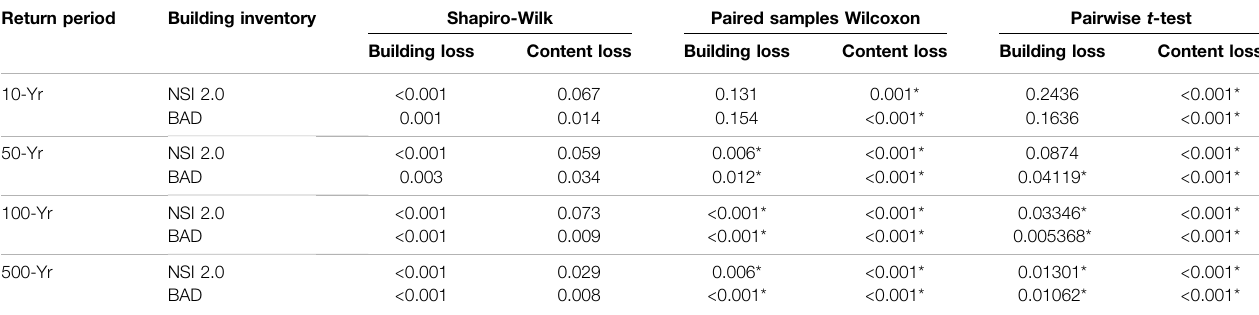
TABLE 10 | As in Table 9 , but for input in the FAST.